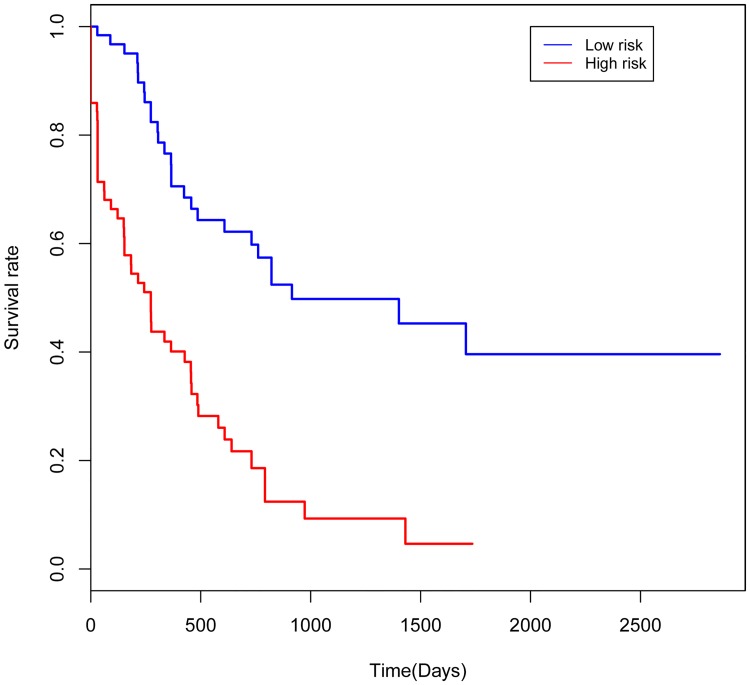
Kaplan-Meier curves showing AML patients dichotomized based on risk score in the training group.High risk is defined as a risk score ≥ the median, and low risk is defined as a risk score < the median in the training group.